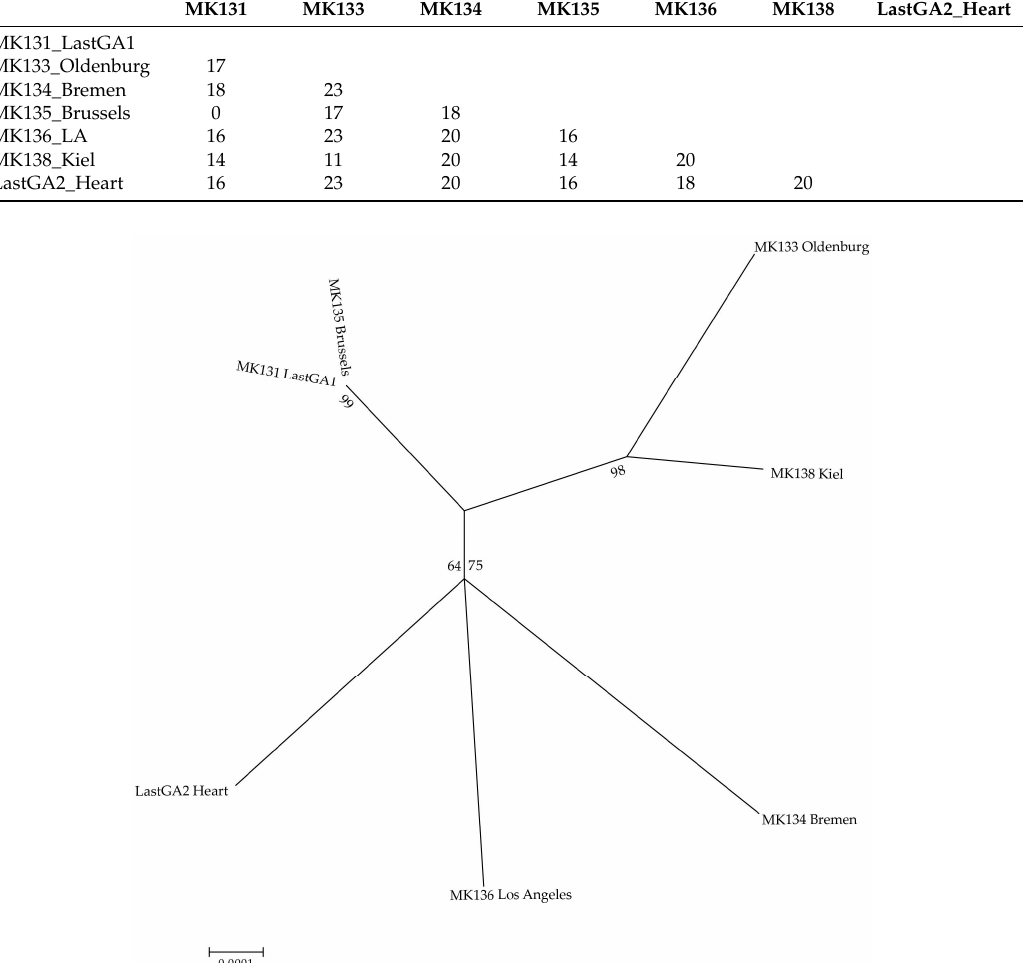
Figure 4. Maximum liklihood reconstruction of phylogenetic relationships between individuals, under the relaxed filtering settings. Branch labels are bootstrap support values for the respective sample. Evolutionary analyses were conducted in MEGA7 [35].